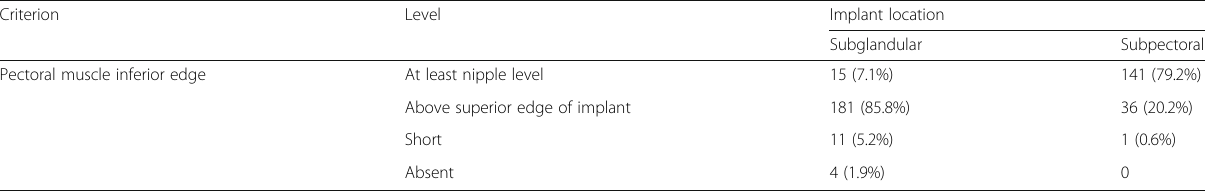
Criterion Pectoral muscle inferior edge